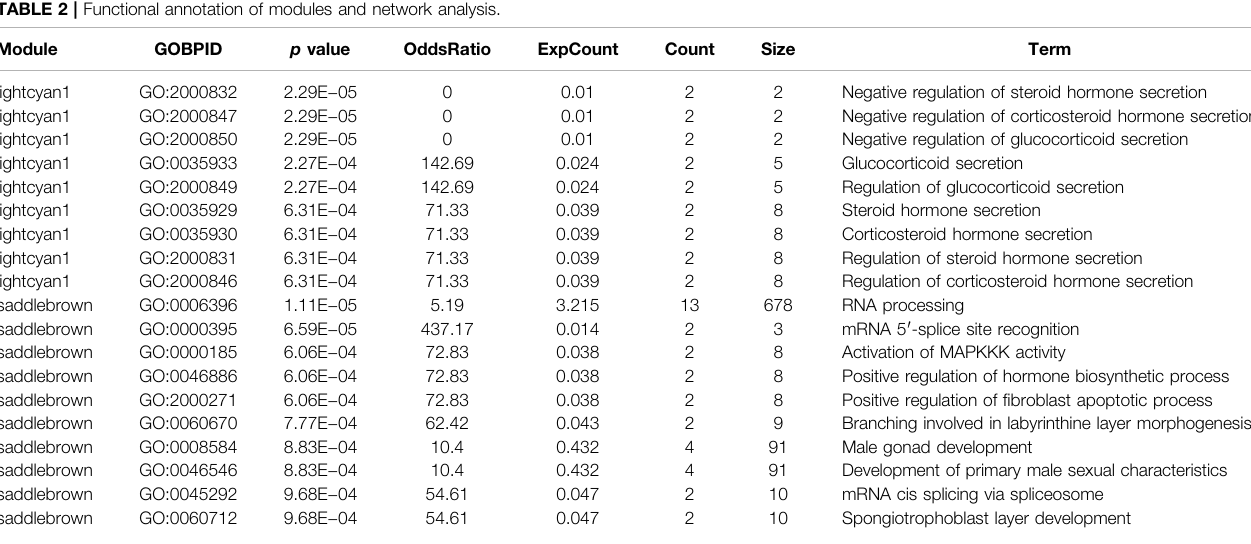
TABLE 2 | Functional annotation of modules and network